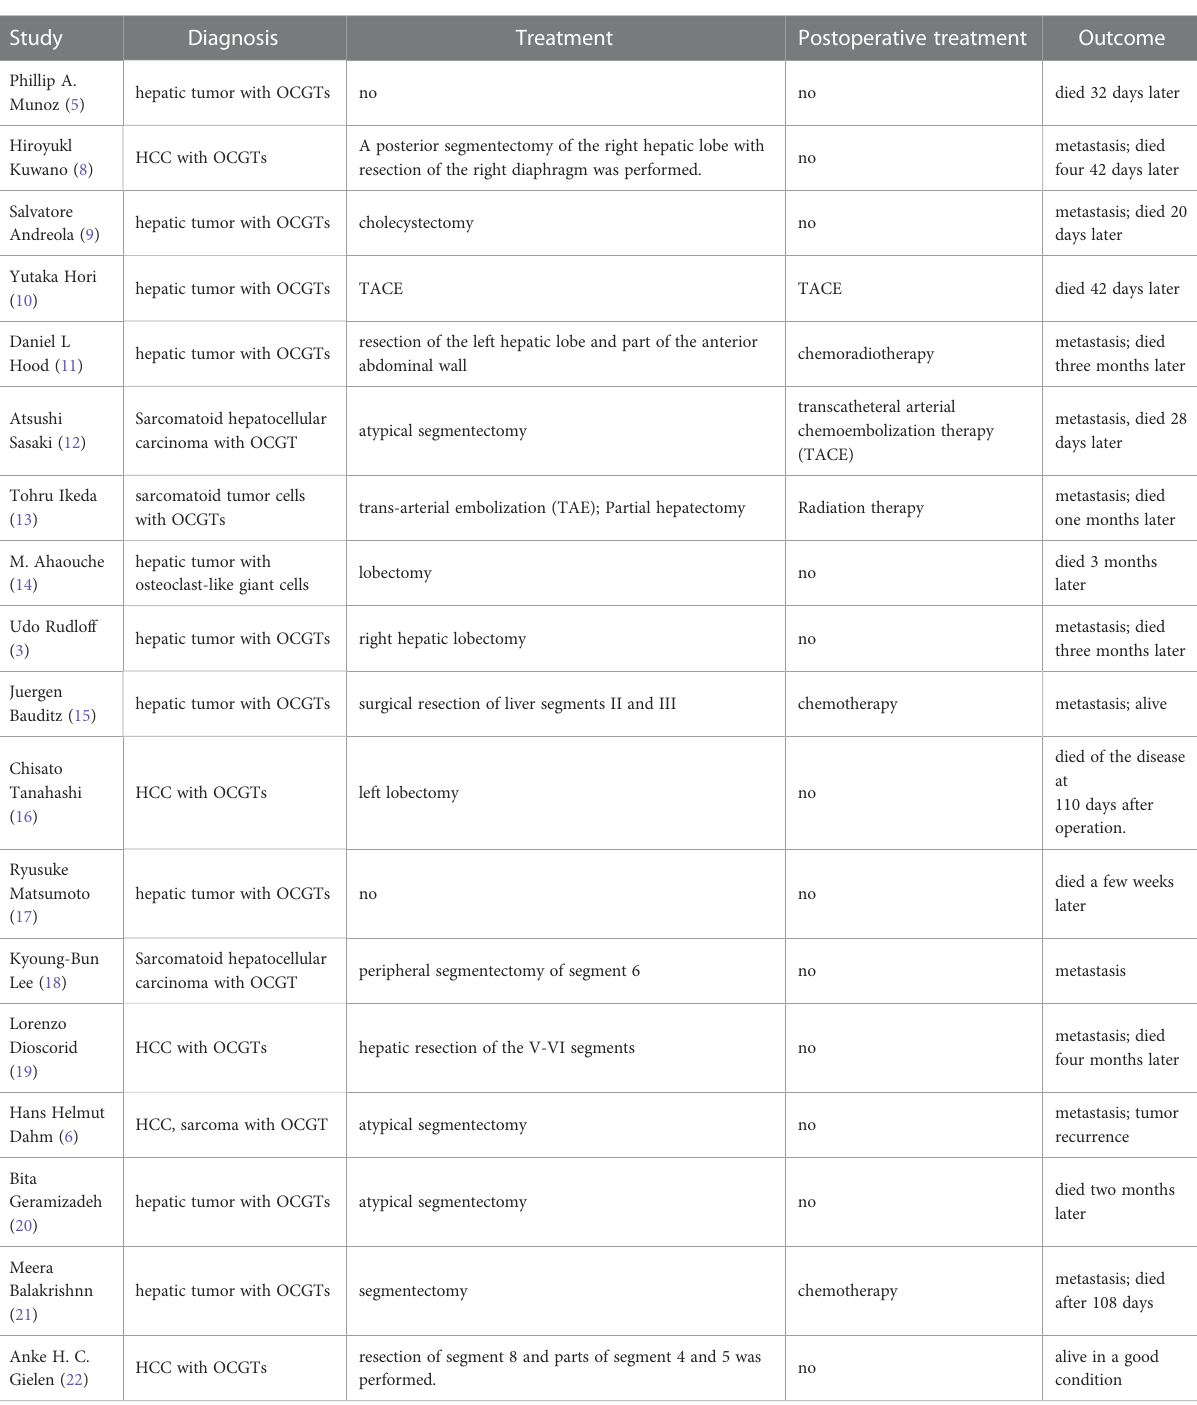
TABLE 4 Prognosis of hepatic tumor with